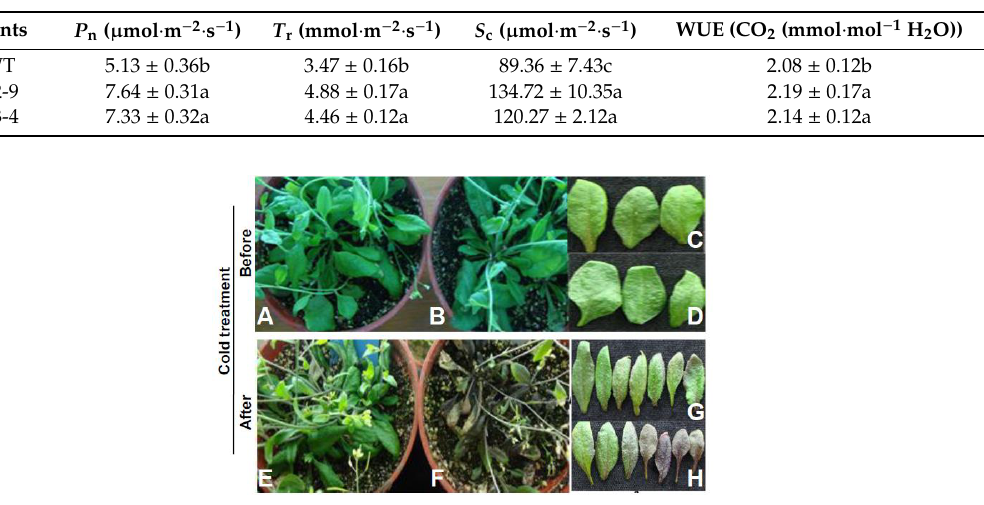
Figure 4. The phenotype of CsICE1 transgenic arabidopsis plants. The plant phenotypes of transgenic ( A , C , E , G ) and wild type ( B , D , F , H ) observed before and after cold treatment (4 °C for 14 days). To quantify the photosynthetic and transpiration capacity of transgenic lines under low temperature, the physiological parameters, including the P n , T r , S c , and WUE were investigated. The results showed that the values of P n, T r, S c in both WT and transgenic plants decreased under 3d cold treatment (Table 2). However, the values of P n, T r, S c in transgenic lines declined to a lesser extent than WT plants. In addition, WUE showed a similar trend with P n, T r, and S c under low temperatures. Table 2. The effects of cold treatment on the net photosynthetic rate ( P n), transpiration rate ( T r), stomatal conductance ( S c), and water use efficiency (WUE) of WT and transgenic plants. Data were shown as mean ±SD; different letters presented significant differences among columns ( p < 0.05). WT presented wild-type plants.